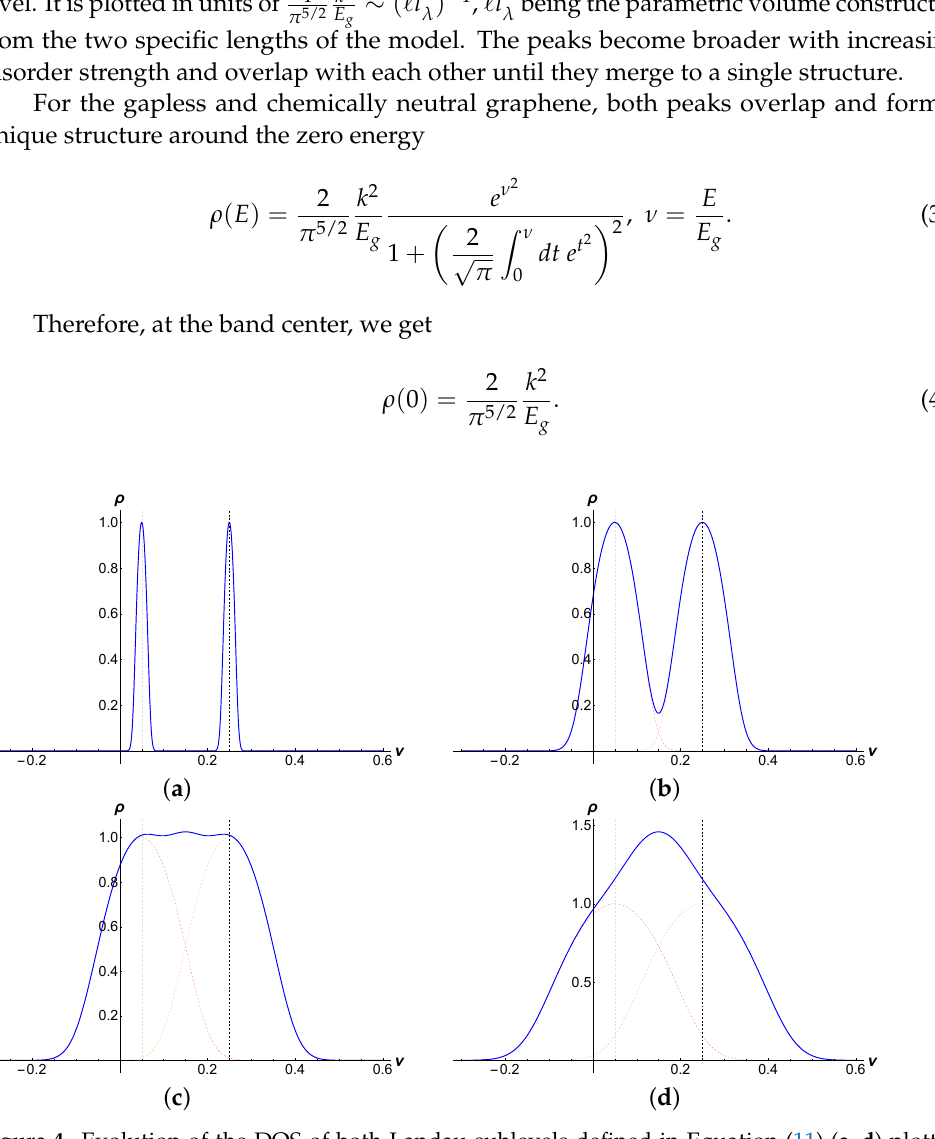
k 2 with increasing disorder strength as a function E g π 5/2 / t = 0.15, ∆ / t = 0.1 and 0 0